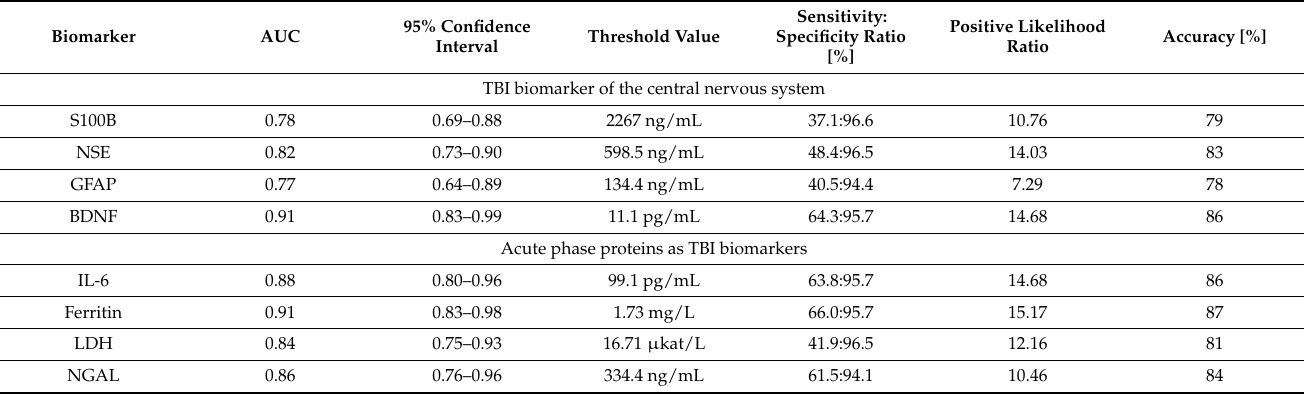
Table 1. A threshold value analysis (overall diagnostic accuracy, accentuated for specificity) for the biomarkers shown in Figure 2 is depicted. The determined threshold values are depicted in blue. AUC = area under the curve; TBI = traumatic brain injury.